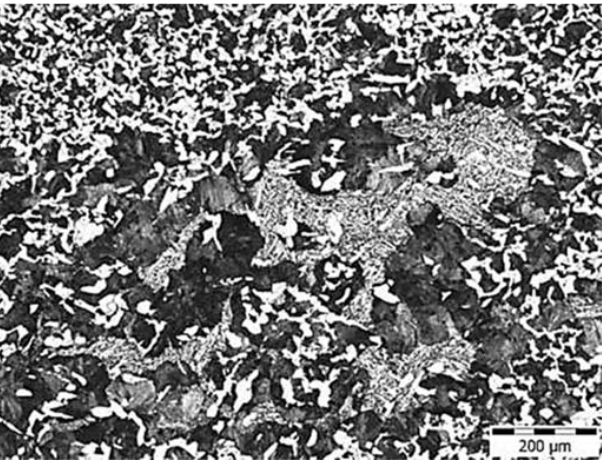
Figure 15. Microstructure in the axial area of CMnCr steel with 0.08 wt. % Bi.